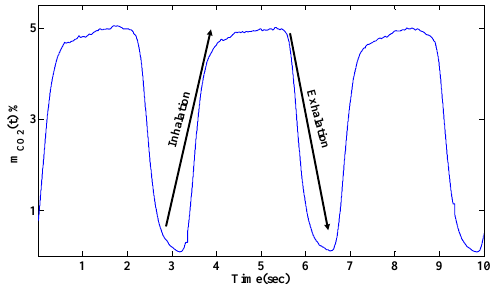
Figure 3: Variation of the CO 2 during the respiration in 10 second that has been experimentally measured [8].